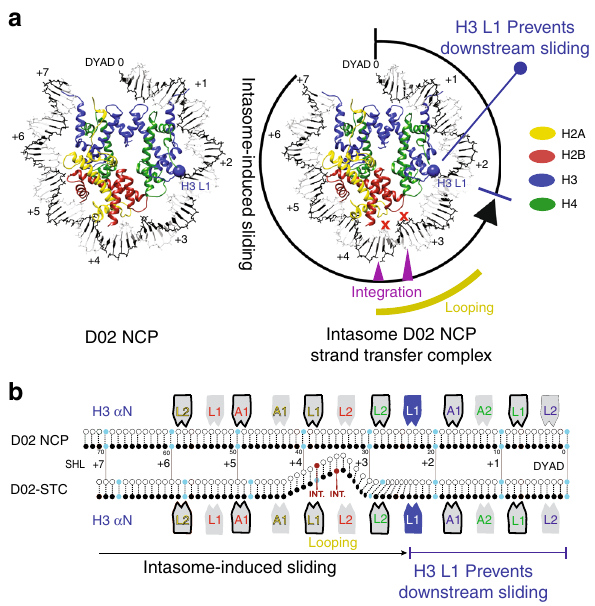
Fig. 4 Integration-promoted DNA sliding observed by cryo-EM. a On the left, slabbed view of the isolated D02 NCP. Histone H3 L1 element is highlighted with a blue ball. On the right, DNA looping required for retroviral integration causes a shift in the DNA register, which extends from SHL 7 to 2. Histone H3 L1 element prevents downstream DNA sliding. b Schematic representation of integration-induced NCP